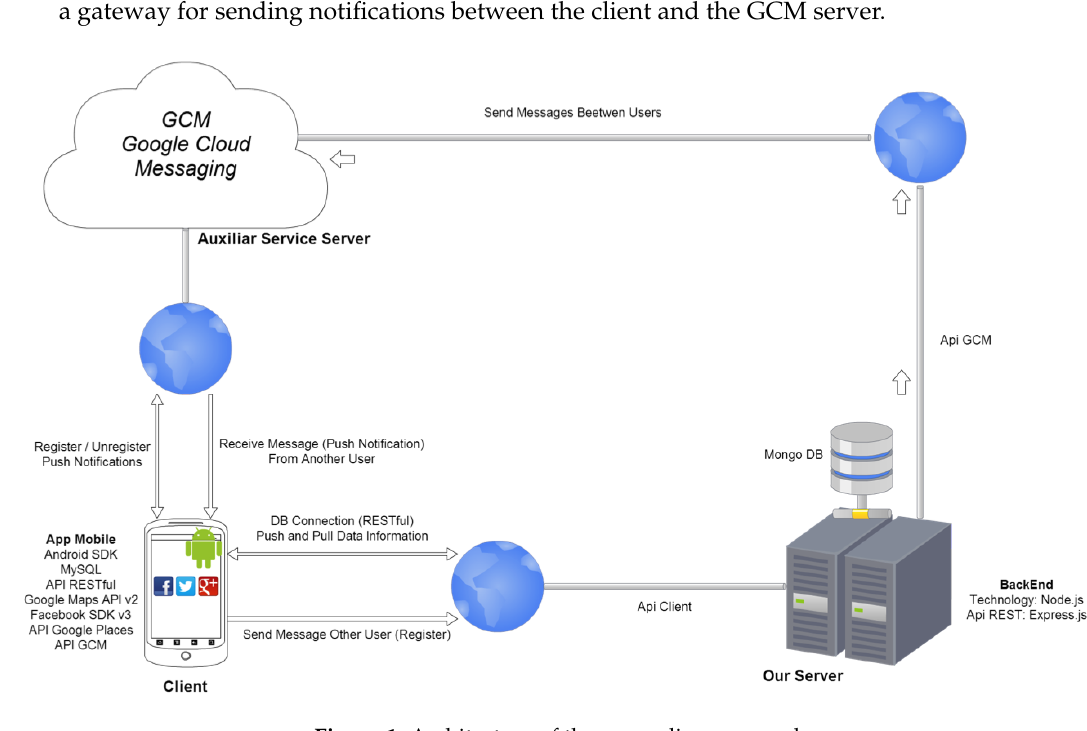
Figure 1. Architecture of the carpooling